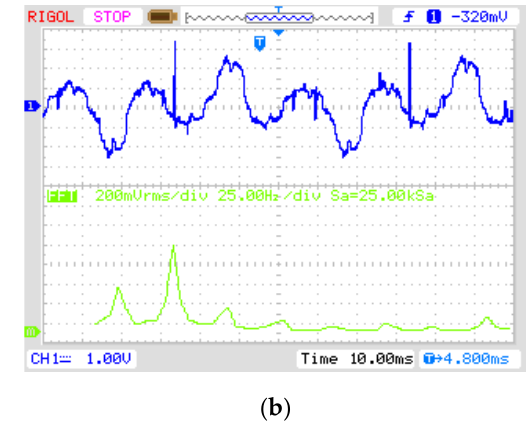
Figure 16. Practically recorded results for one-third output frequency with pulse voltage regulation capabilities: ( a ) output voltage and its FFT spectrum; ( b ) input current and its FFT spectrum. The power quality improvement of the input current for the pulse non-adjustment approach is described in Figure 17. FFT spectrum of the output voltage for one-half and the one-third output frequency is illustrated in Figure 17a,b. It is clearly shown that there is improvement in the harmonic profile of the output voltage for one-half frequency as the 50 Hz harmonic component has been successfully removed. The magnitude of the low-frequency harmonics for the one-third output frequency voltage slightly increases, raising its harmonics factor from 55% to 68%. However, the power quality indexes of the input current for the frequencies mentioned above are approaching their ideal value. The pulse non-regulated topology is very simple to realize, and its input current quality is inherently improved as its flow is continuous.